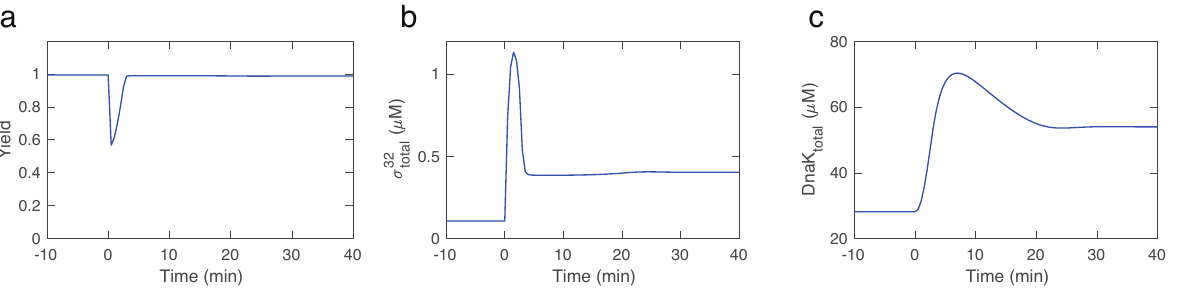
Figure 6. Simulation of the created SBML model for the heat shock response model. ( a ) Yield, ( b ) total σ 32 , and ( c ) total DnaK. Heat shock occurs at 0 min and is implemented through an increase in the rate constant for protein denaturing. Yield is the fraction of folded proteins in a pool of total proteins, i.e., Yield = P fold / ( P fold + P unfold + P unfold _ DnaK ) . Not all variables are shown, for clarity. This model was created by KinModGPT with text-davinci-003 . We tuned the kinetic parameters before the